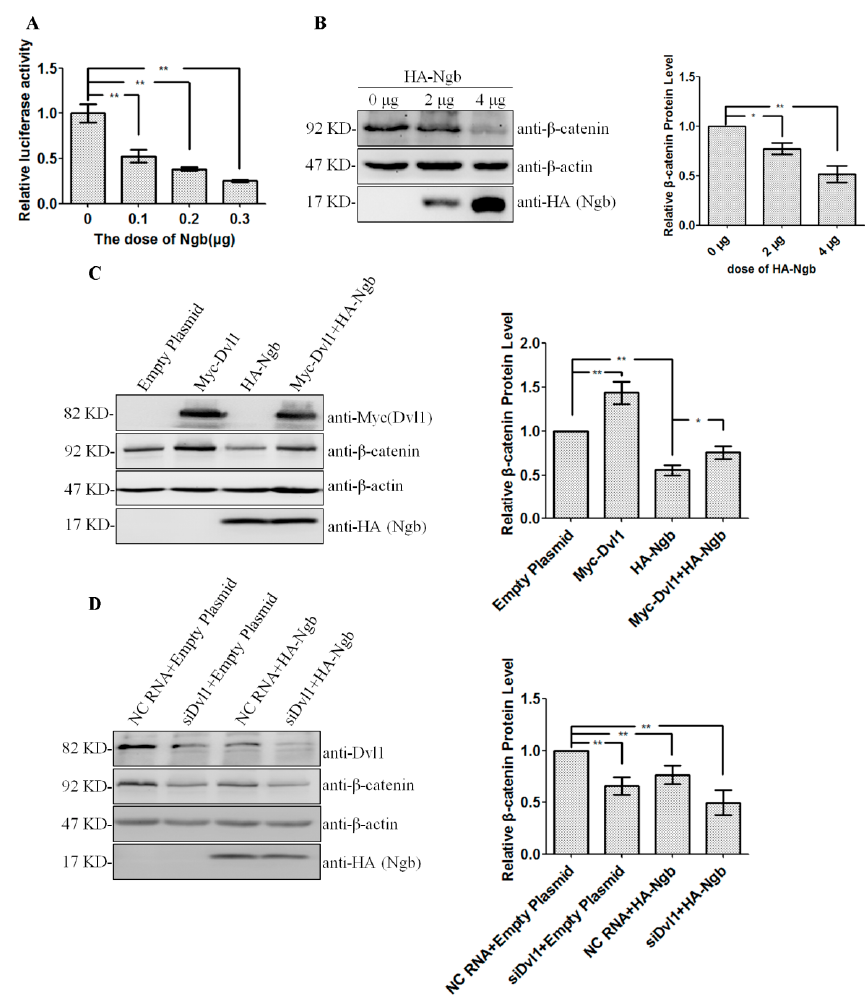
Figure 3. Ngb inhibits Wnt signaling pathway through decreasing Dvl1. ( A ) SK-N-SH cells were seeded on 24-well plates. Increased amount of HA-Ngb was co-transfected with constant amount of PRL-TK and pTOPFLASH. Luciferase activity (Mean ± SD) was measured after 24 h post-transfection. n = 3, ** p < 0.01 compared with controls. ( B ) Increased amount of HA-Ngb was transfected into SK-N-SH cells. The level of β -catenin proteins was detected by western blot. Densitometric analysis of western blot was performed. β -actin served as equal loading controls. (Mean ± SD). n = 3, ** p < 0.01 versus cells transfected with empty plasmid. ( C ) HA-Ngb or empty plasmid (pCMV-HA) was co-transfected with Myc-Dvl1 or empty plasmid (pCMV-Myc). Densitometric analysis of western bolt was performed. β -actin served as equal loading controls. (Mean ± SD). n = 3, * p < 0.05, ** p < 0.01 versus controls as described. ( D ) HA-Ngb or empty plasmid (pCMV-HA) was co-transfected with NC siRNA or Dvl1 siRNA. Western blot was performed after transfection for 48 h. Densitometric analysis of western bolt was performed. β -actin served as equal loading controls. (Mean ± SD). n = 3, ** p < 0.01 versus controls.